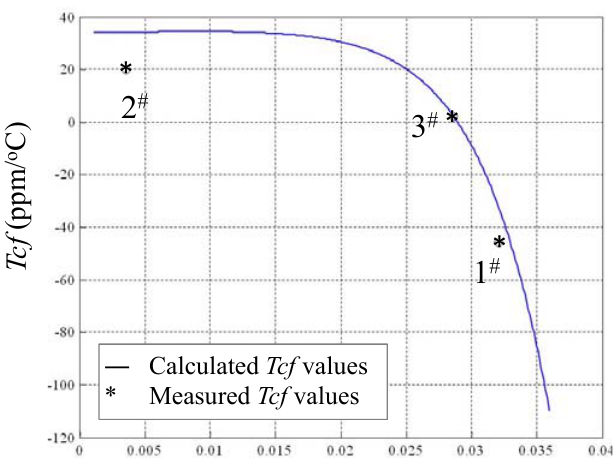
Figure 10. Tcf comparison between the experimental results and theoretical